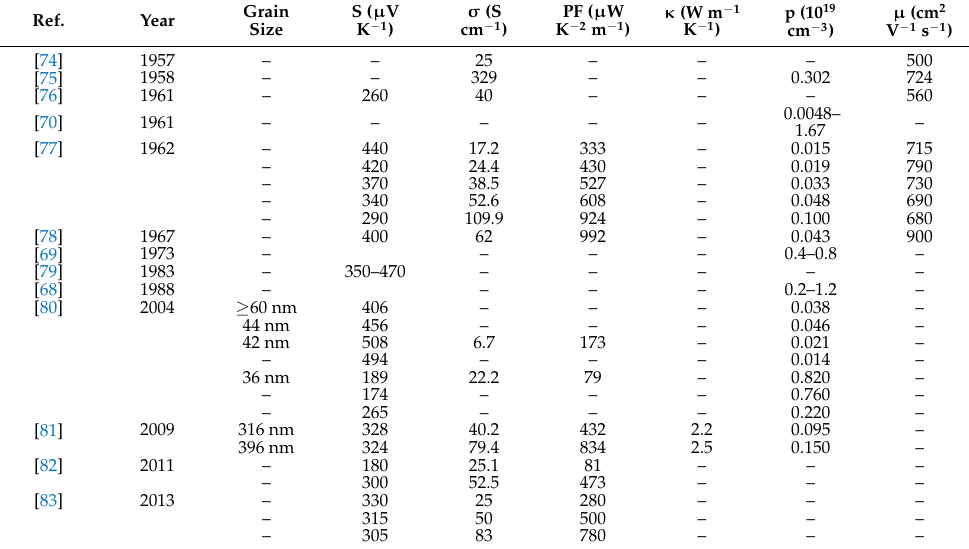
Table 1. Summary of electrical and thermoelectric properties of Te-rich PbTe.